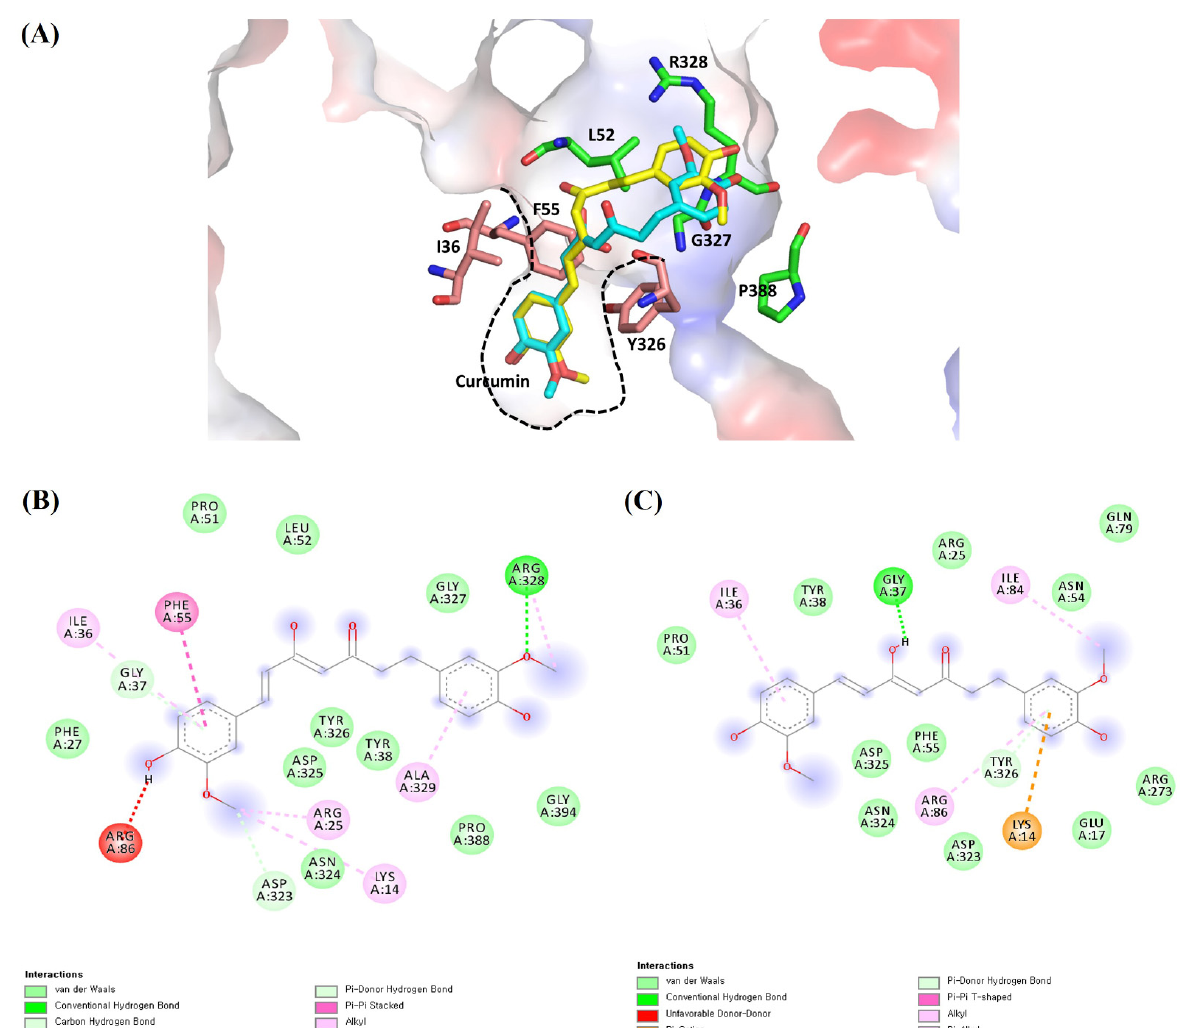
Figure 5. The proposed ligand–receptor interactions of curcumin–AKT1 from molecular docking: ( A ) ligand–receptor interactions of the keto (cyan) and enol (yellow) forms of curcumin with AKT1 showing the electrostatic surface in the 3D representation. Half of the curcumin is tightly bound in AKT1 with the hydrophobic residues (pink) of Ile36, Phe55, and Y326, and the other half is partially exposed to solvent and interacts with the surface residues (green) of Leu52, Gly327, Arg328, and Pro388. The tight hydrophobic pocket is shown in the dashed black line; ( B ) the detailed molecular interac- tions of the keto form of curcumin with AKT1 in the 2D representation; ( C ) the detailed molecular interactions of the enol form of curcumin with AKT1 in the 2D representation.